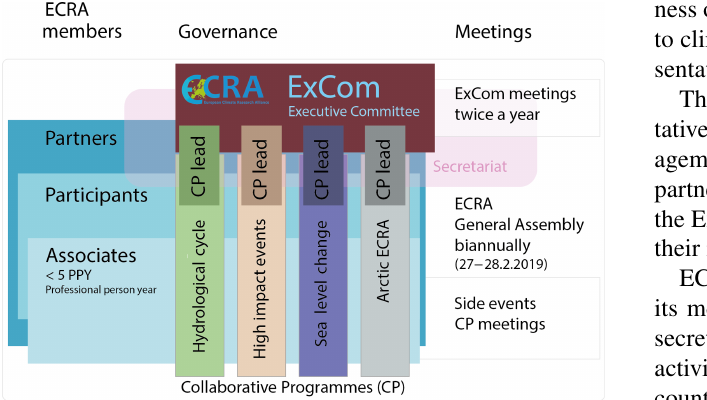
Figure 2. The organisation, members and meetings of ECRA. The four Collaborative Programmes frame research activities and are constituted of different members. Support and governance come from the Executive Committee and the secretariat (©